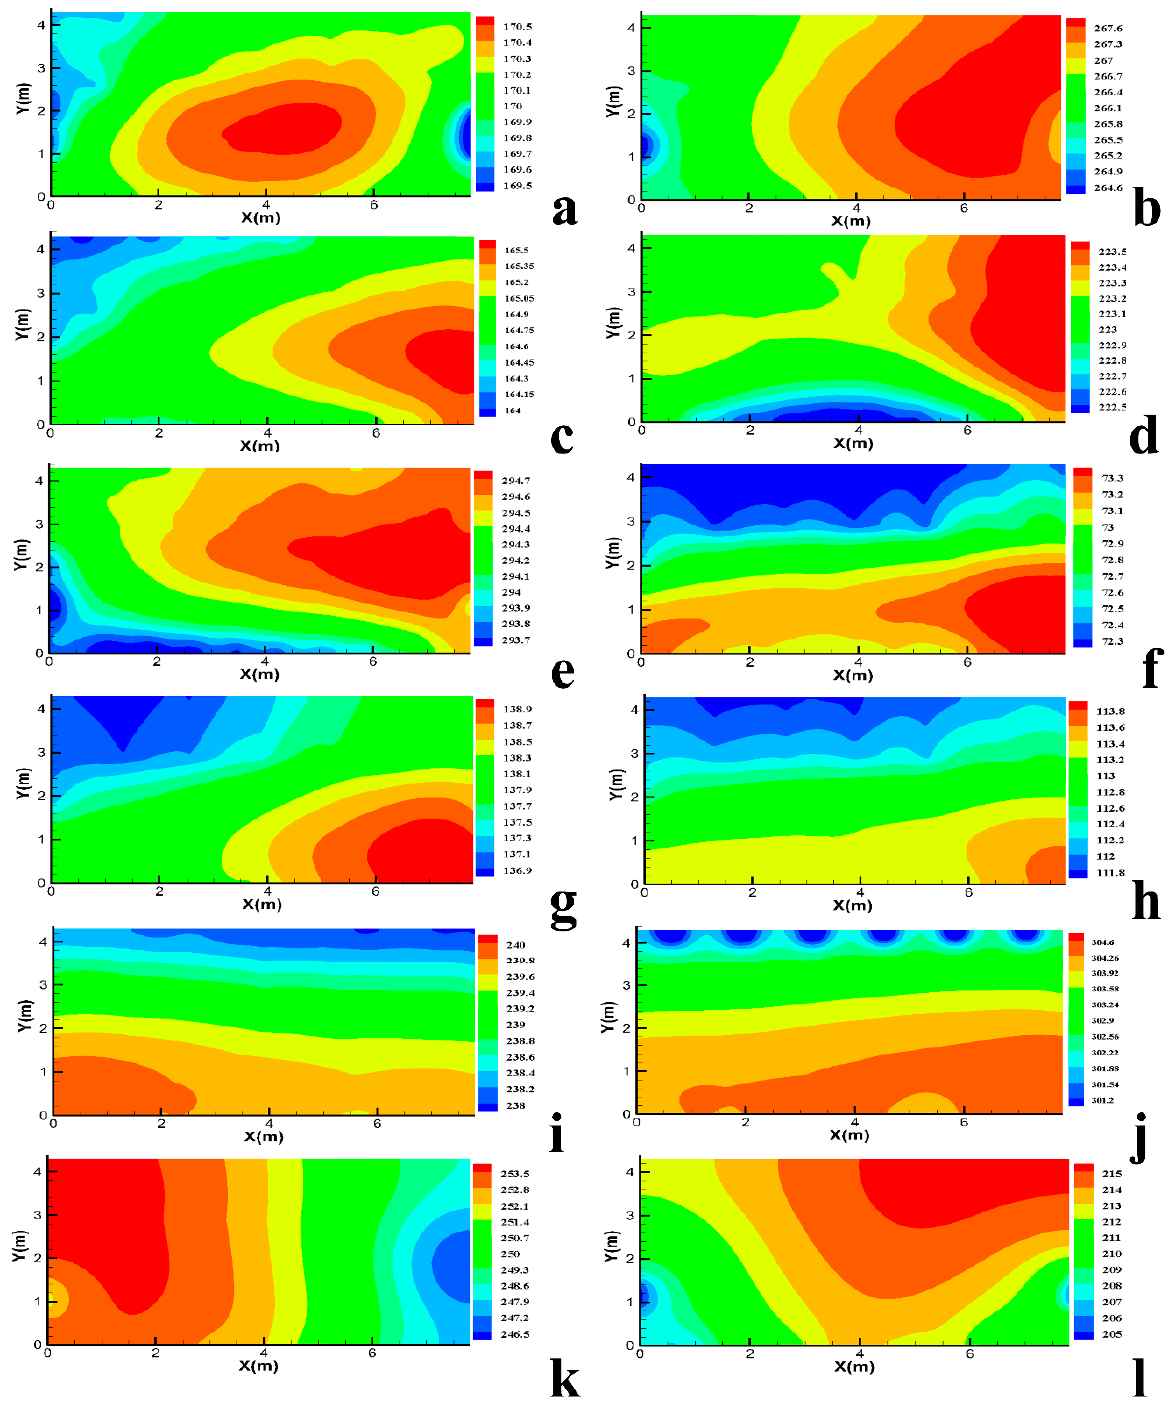
Figure 11. Air age cloud diagrams of different scenarios (ACH = 5), ( a – l ) MV-1 – IJV-7.